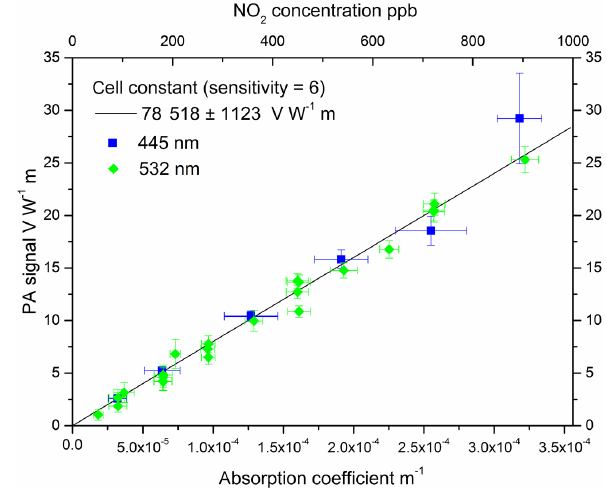
Figure 3. Cell constant determined for the lock-in sensitivity 6 from calibration measurement with NO 2 at 445 and 532nm. Note that some of the 532nm measurements were performed at sensitivity 7 and were subsequently rescaled to sensitivity